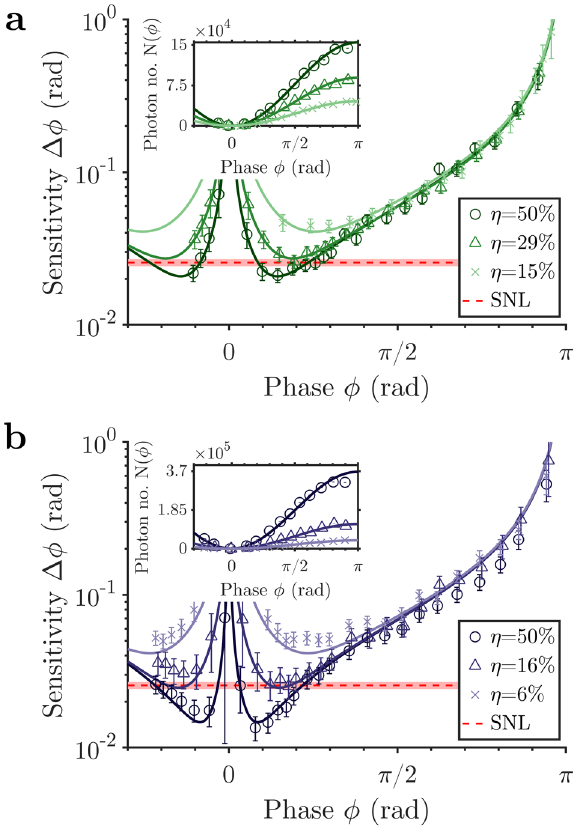
Fig. 3 Phase sensitivity measurements with 15 dB input squeez- ing and N α = 1500 photons in the coherent beam. The red dashed line marks the SNL and the solid lines are the theoretical predictions. The error bars represent the standard error of the mean with a sample size of 1000. The insets show the photon number dependence on the phase and the error bars are too small to be seen. a Parametric ampli fi cation with G 2 = 3.1. Circles, triangles and crosses show measurements with detection ef fi ciency η = 50%, 29% and 15%, respectively. b Parametric ampli fi cation with G 2 = 3.6. Circles, triangles and crosses are for η = 50%, 16% and 6%, respectively.